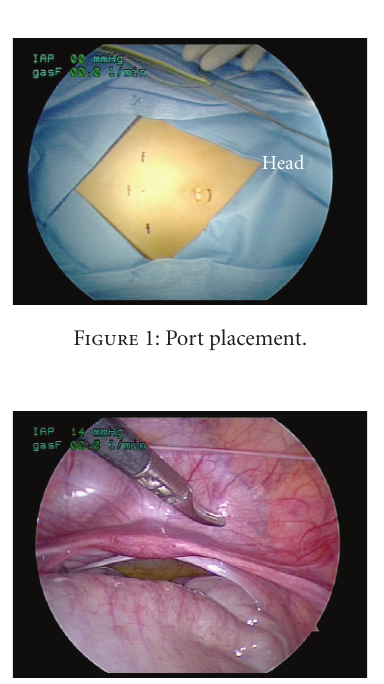
Figure 2: The peritoneal envelope is opened just adjacent to the bladder.